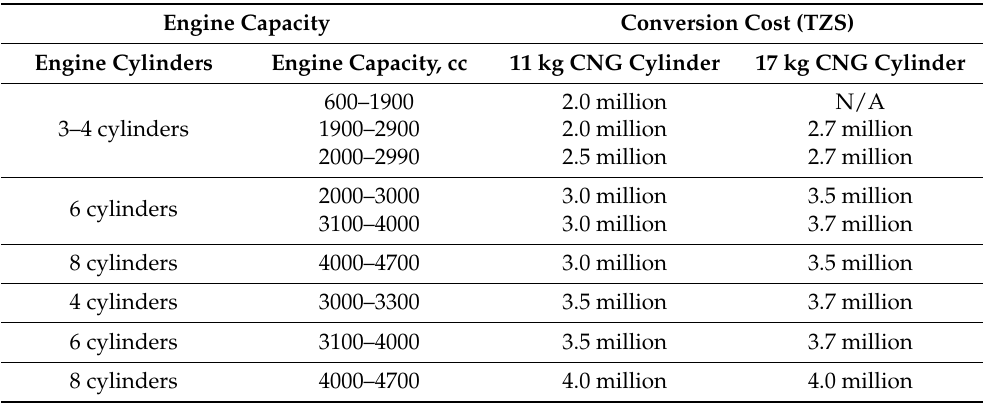
Table 4. Costs of retrofitting petrol-fueled light-duty and medium-duty vehicles to